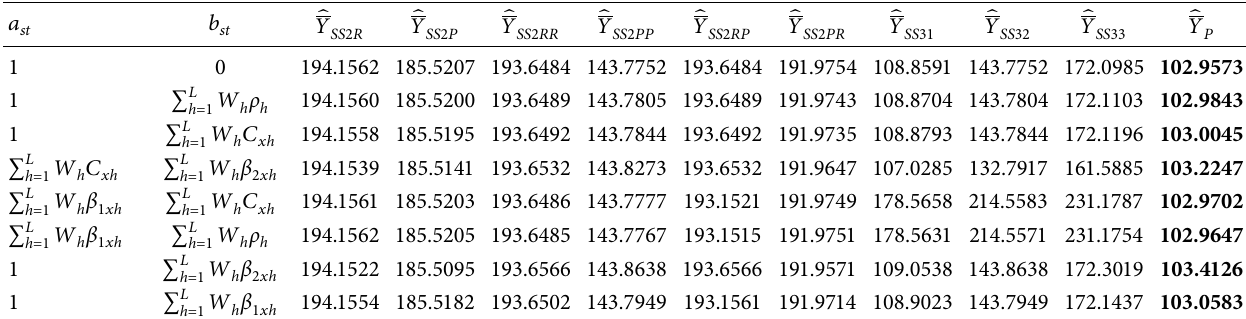
Table 4: Minimum MSEs of different estimators based on real